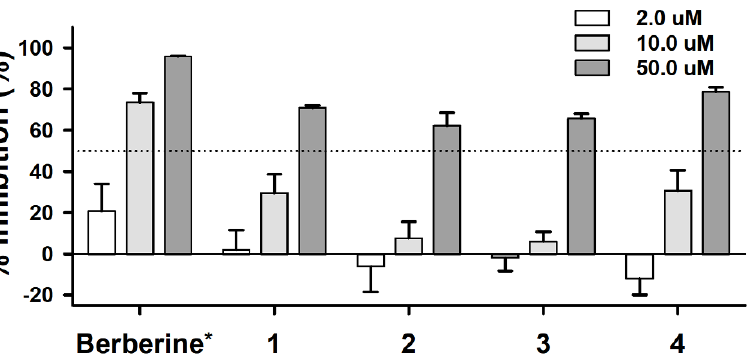
Figure 4. AChE-inhibitory activity (%) of the four compounds ( 1 – 4 ) at three concentrations by five-fold dilution. * Concentrations of the control (berberine) were 0.04, 0.2, and 1.0 μM, respectively.